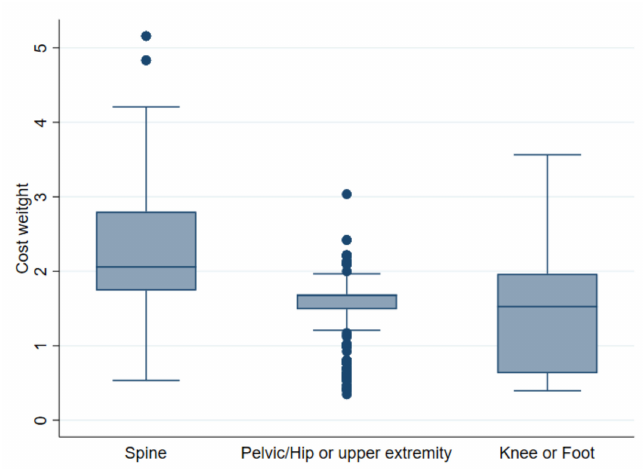
Figure 9. Box plot of cost weight according to surgical site.